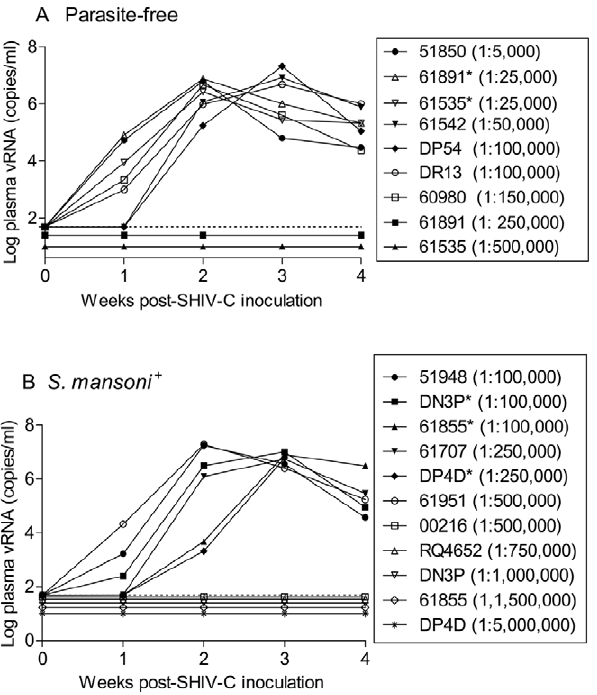
Figure 3. Viral RNA loads of parasite-free and S. mansoni - infected RM after SHIV-C challenge. (A & B) viral RNA loads were compared between parasite-free and S. mansoni -infected RM during acute infection. During the first four weeks post-challenge, plasma samples were analyzed weekly for viral RNA loads. The horizontal dotted line indicates the lower limit of detection in the PCR assay ( , 50 viral RNA copies/ml) [14,15]. *, animals were first exposed to higher dilution of the virus as indicated in the figure. If systemic infection failed to occur after the initial dose, the monkeys were re-exposed to a lower virus dilution, which proved to be infective.